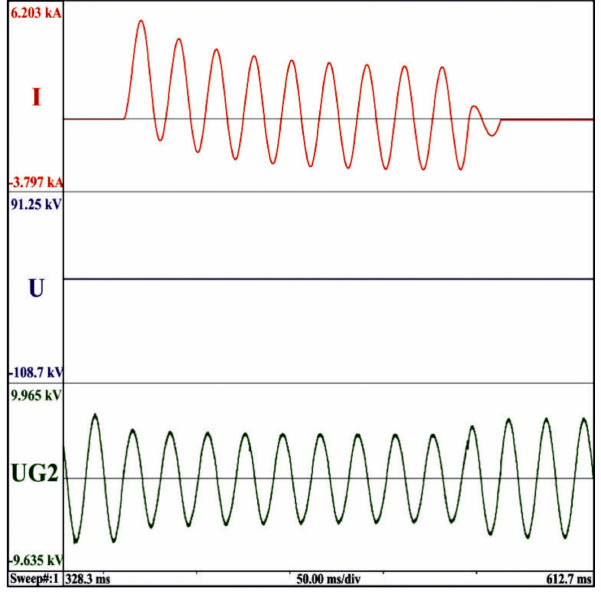
Figure 11. Oscillogram obtained during calibration for I 2